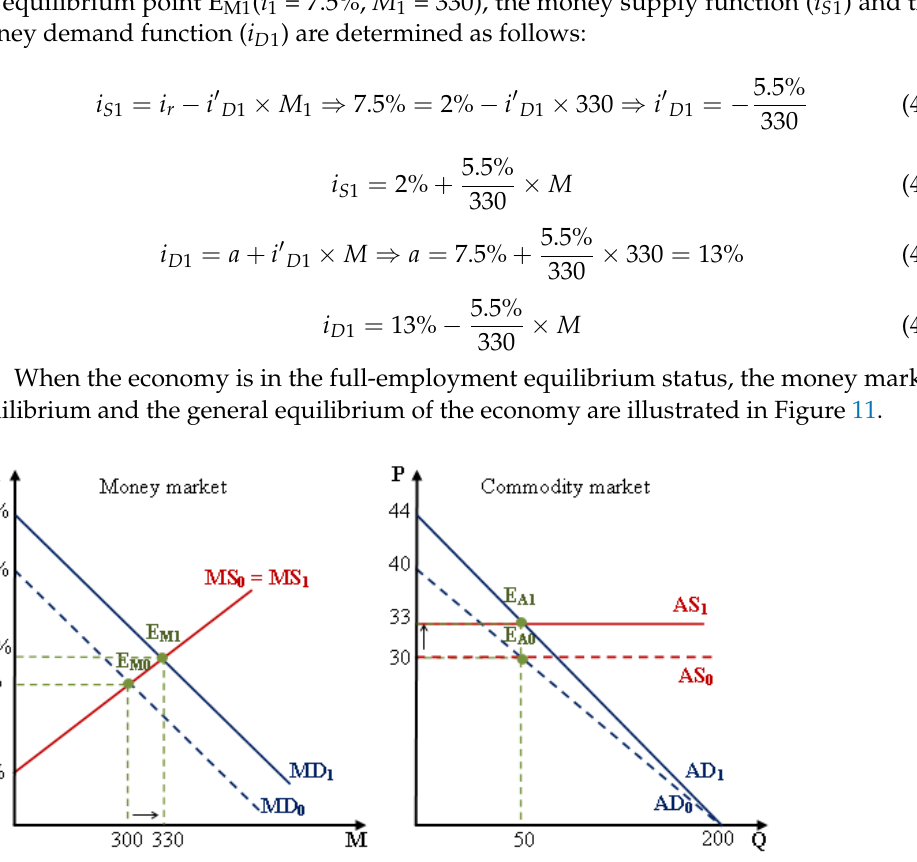
Figure 11. Case of the full-employment equilibrium economy